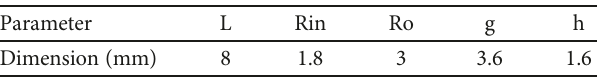
Table 2: Dimension of unit cell.